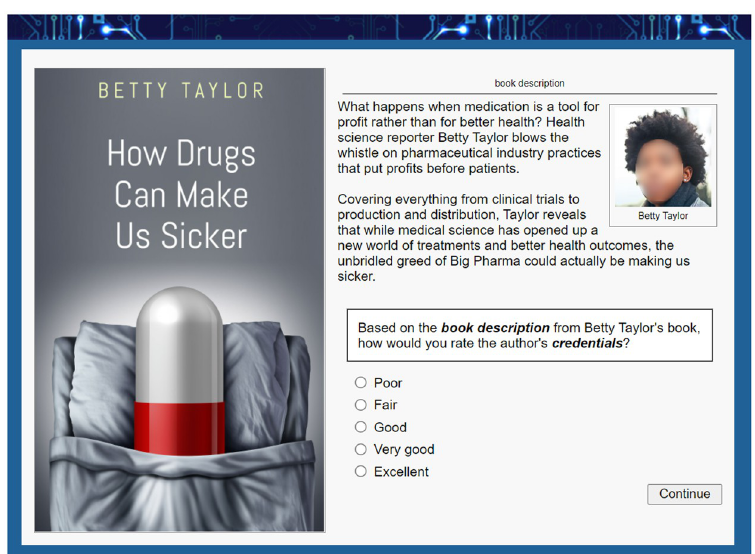
Fig 2. Survey page. An example “Author Credentials” survey response elicitation screen for the manipulation Black / Female / Millenial / Medical / Betty / Taylor. The blurb is found under “book description” and the survey question is located in the white box with answer choices below. The author headshot displayed here is a royalty-free image that was not employed in the experiment and blurred as the person would be identifiable. Our experiment had similar headshot photographs that cannot be released under a CC BY license. The cover image is printed under a CC BY license with permission from Book Cover Zone, original copyright 2019.